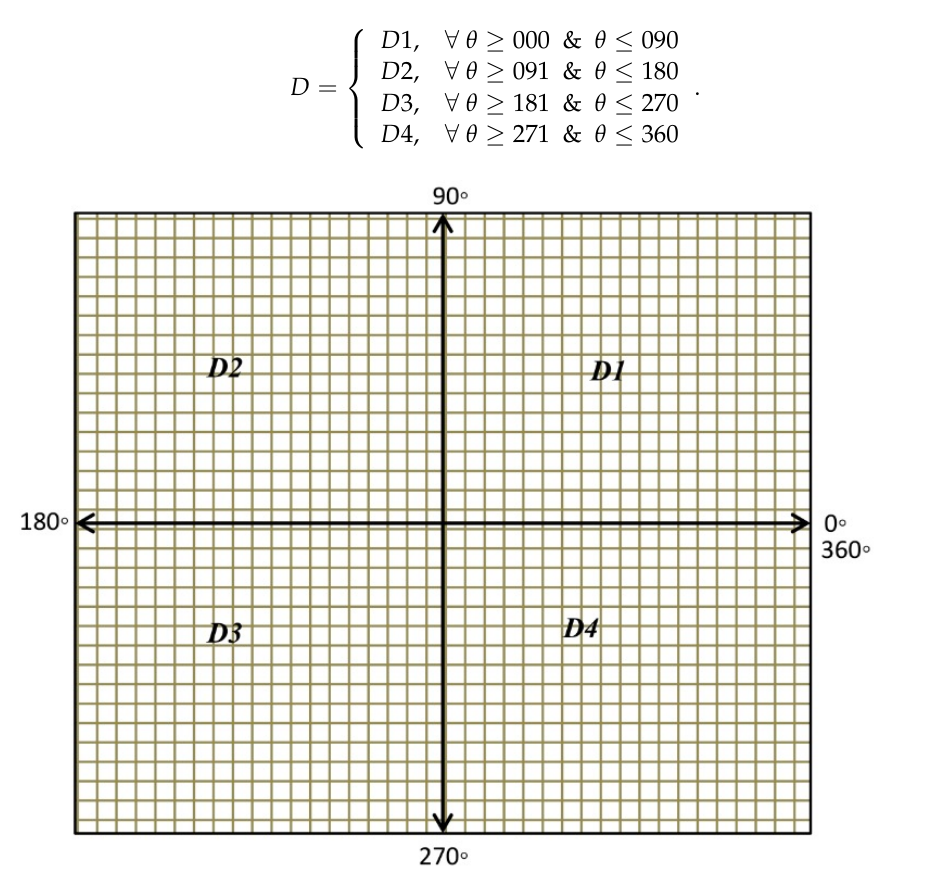
Figure 3. Direction-based classification of